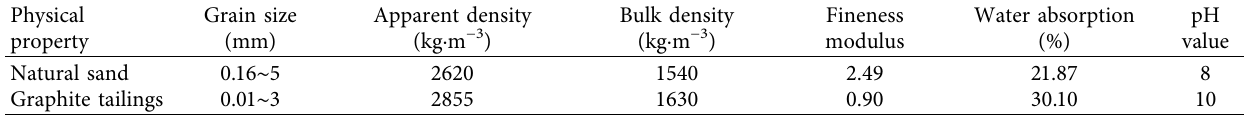
Table 1: Physical properties of graphite tailings sand and natural sand.